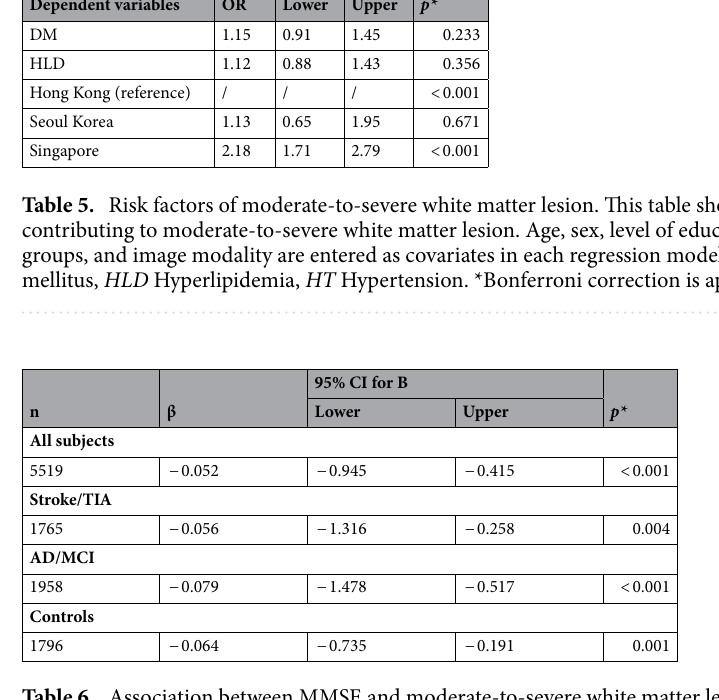
Table 6. Association between MMSE and moderate-to-severe white matter lesion. This table shows the association between moderate-to-severe white matter lesion contributing to cognition. Age, sex, level of education, Asian cities and hypertension are entered as covariates in each regression model. MMSE Mini- mental state examination. *Bonferroni correction is applied to the alpha ( α = 0.0125).